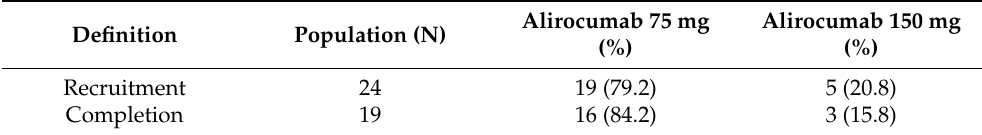
Table 1. Study Population and Alirocumab